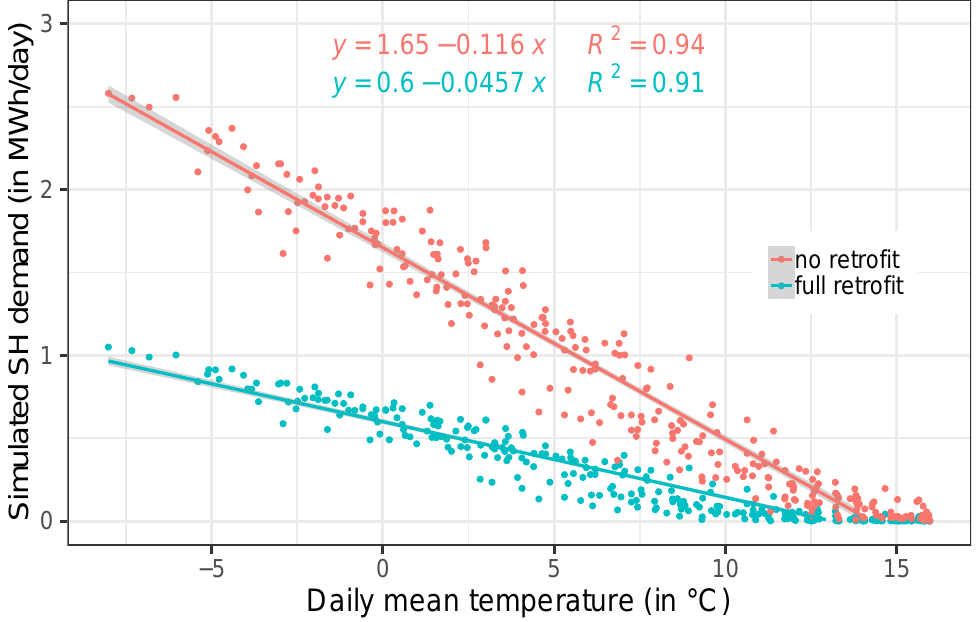
Figure 5. Linear regression of the daily space heating (SH) demand calculated with the CESAR model for a set of 500 single- and 500 multi-family houses—representative for all Switzerland—with no retrofit and with a full retrofit versus the daily mean temperature at their location. Each dot represents one day of a whole